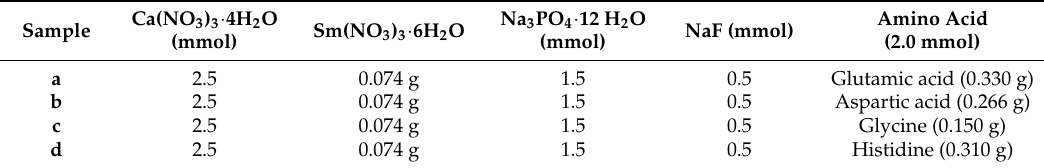
Table 4. Chemical composition of amino assisted